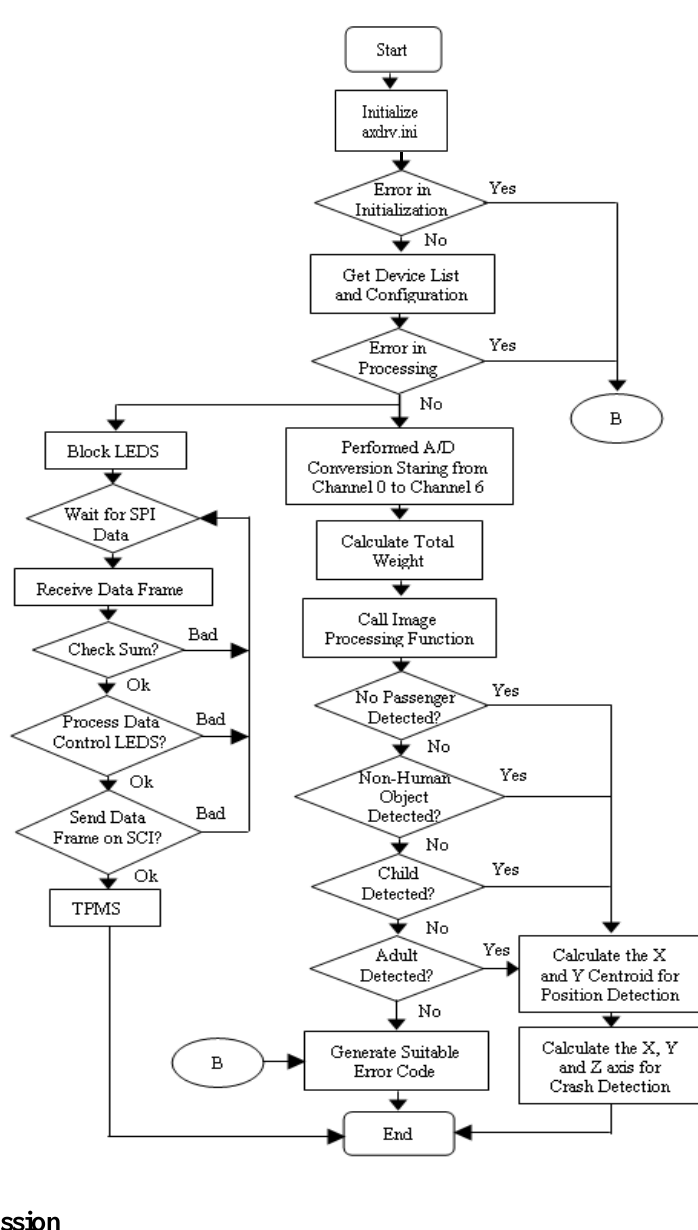
Figure 3. Program flowchart for the integrated